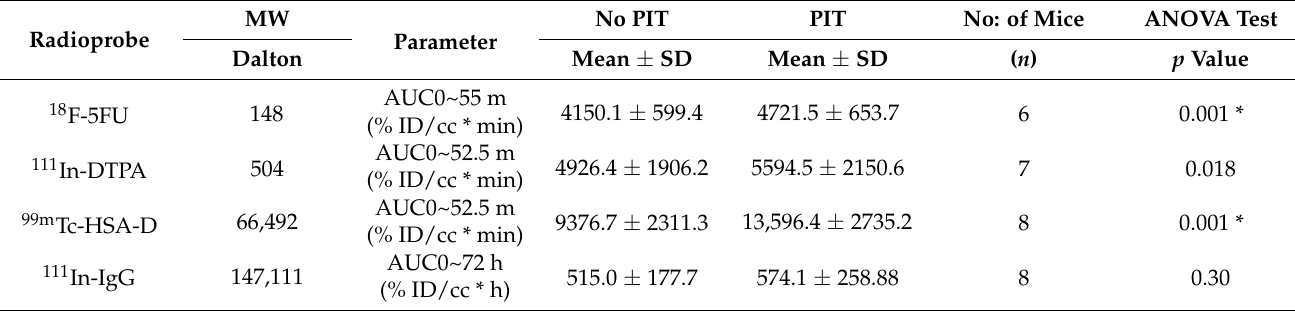
Figure 4. Dynamic PET/CT imaging of 18 F-5FU in tumor-bearing mice. ( A ) Representative PET/CT image at four time points (27.5, 35, 45, and 55 min) after PIT. ( B ) Time-activity curve of average uptake of 18 F-5FU. ( C ) Summed values of the areas under the curve (AUCs) for each time point were significantly increased in PIT-treated tumors (red) compared to untreated tumors (blue). Data are presented as means ± SD ( n = 6), * p < 0.05 for PIT vs. no PIT. Table 1. Summary of super-enhanced permeability and retention (SUPR)